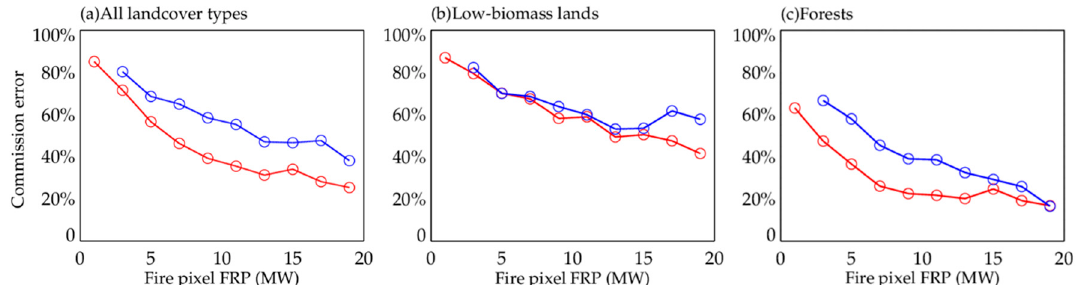
Figure 6. Commission errors of MODIS (blue) and VIIRS (red) for ( a ) all land-cover types; ( b ) low-biomass lands; ( c ) forests.